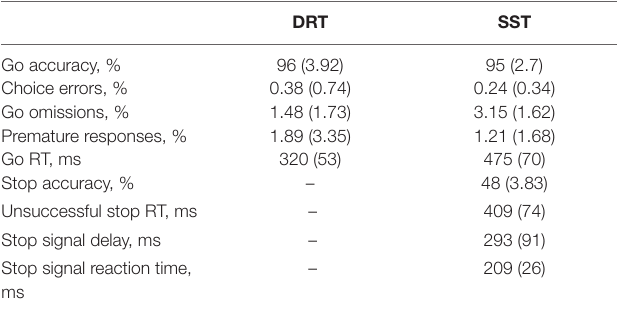
TABLE 1 | Behavioral characteristics.